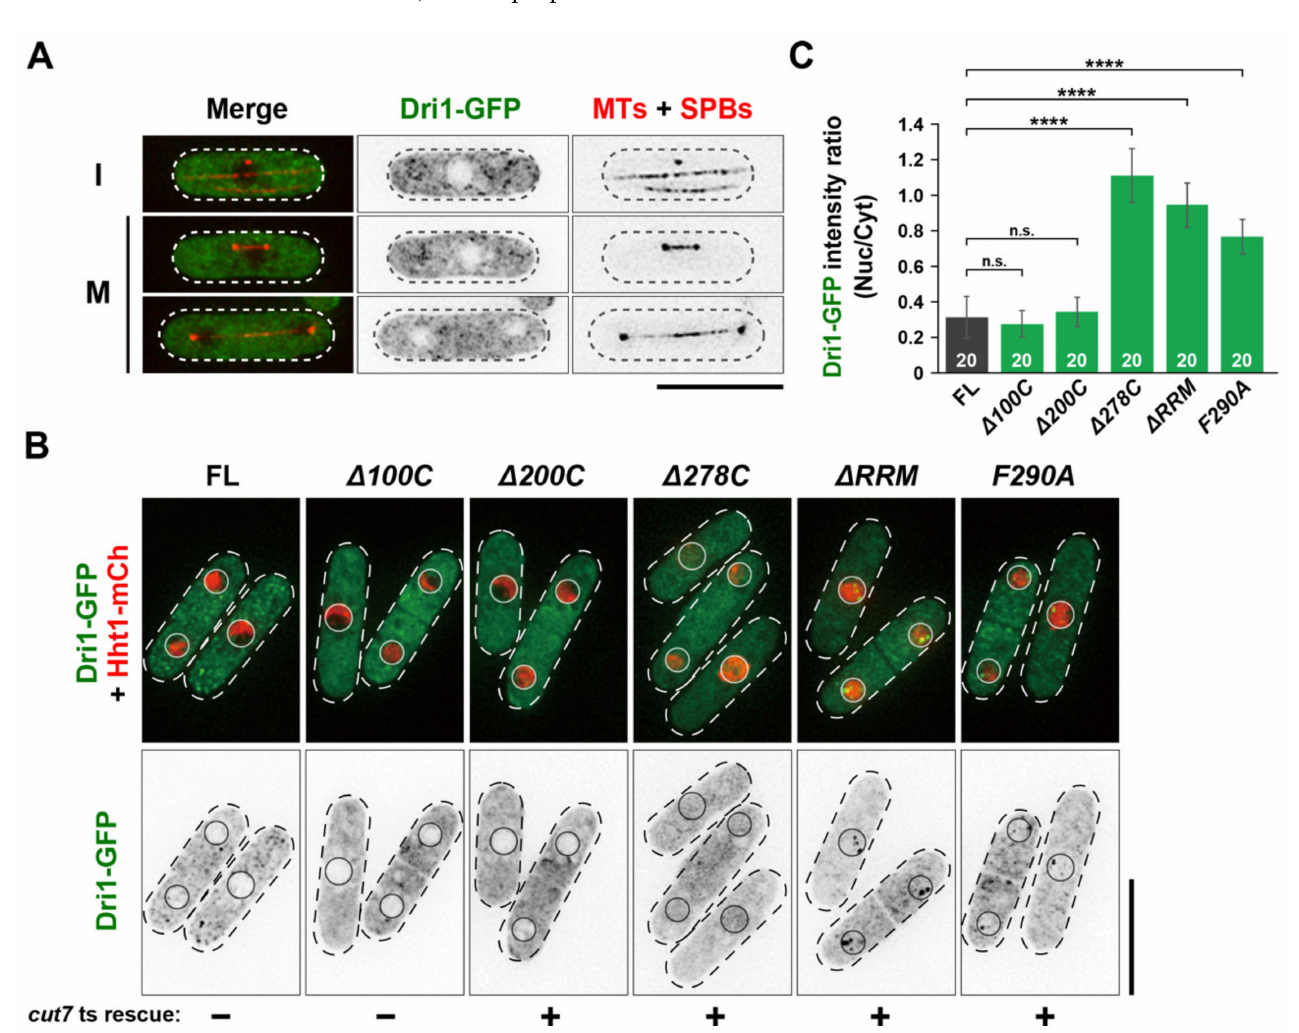
Figure 3. Cytoplasmic localization of Dri1 depends on the RNA recognition motif and RanBP2-type zinc finger domains. ( A ) Dri1 is localized in the cytoplasm throughout the cell cycle. Localization of Dri1-GFP during interphase (I) or mitosis (M) is shown. Cells were grown in rich media at 27 ◦ C. Microtubules are visualized by mCherry-Atb2, while the SPB was marked with Sid4-mRFP [46]. ( B ) The putative RNA-binding domains of Dri1 are essential for its export from the nucleus to the cytoplasm. Cells expressing the GFP-tagged full-length or various truncated/mutated Dri1 (Dri1-GFP) together with the chromosome marker Hht1-mCherry (Histone H3 h3.1) [47,48] were grown in rich media at 27 ◦ C, and their localization was observed. ( C ) The bar graph shows quantification of nuclear enrichment of Dri1-GFP signal. Fold enrichment of Dri1-GFP signal in the nucleus (nucleus/cytoplasm) was quantified. All p -values were obtained from the two-tailed unpaired Student’s t test. Data are presented as the means ± SE (20 cells). ****, p < 0.0001, n.s., not significant. The cell peripheries are indicated with dotted lines. Scale bars, 10 µ